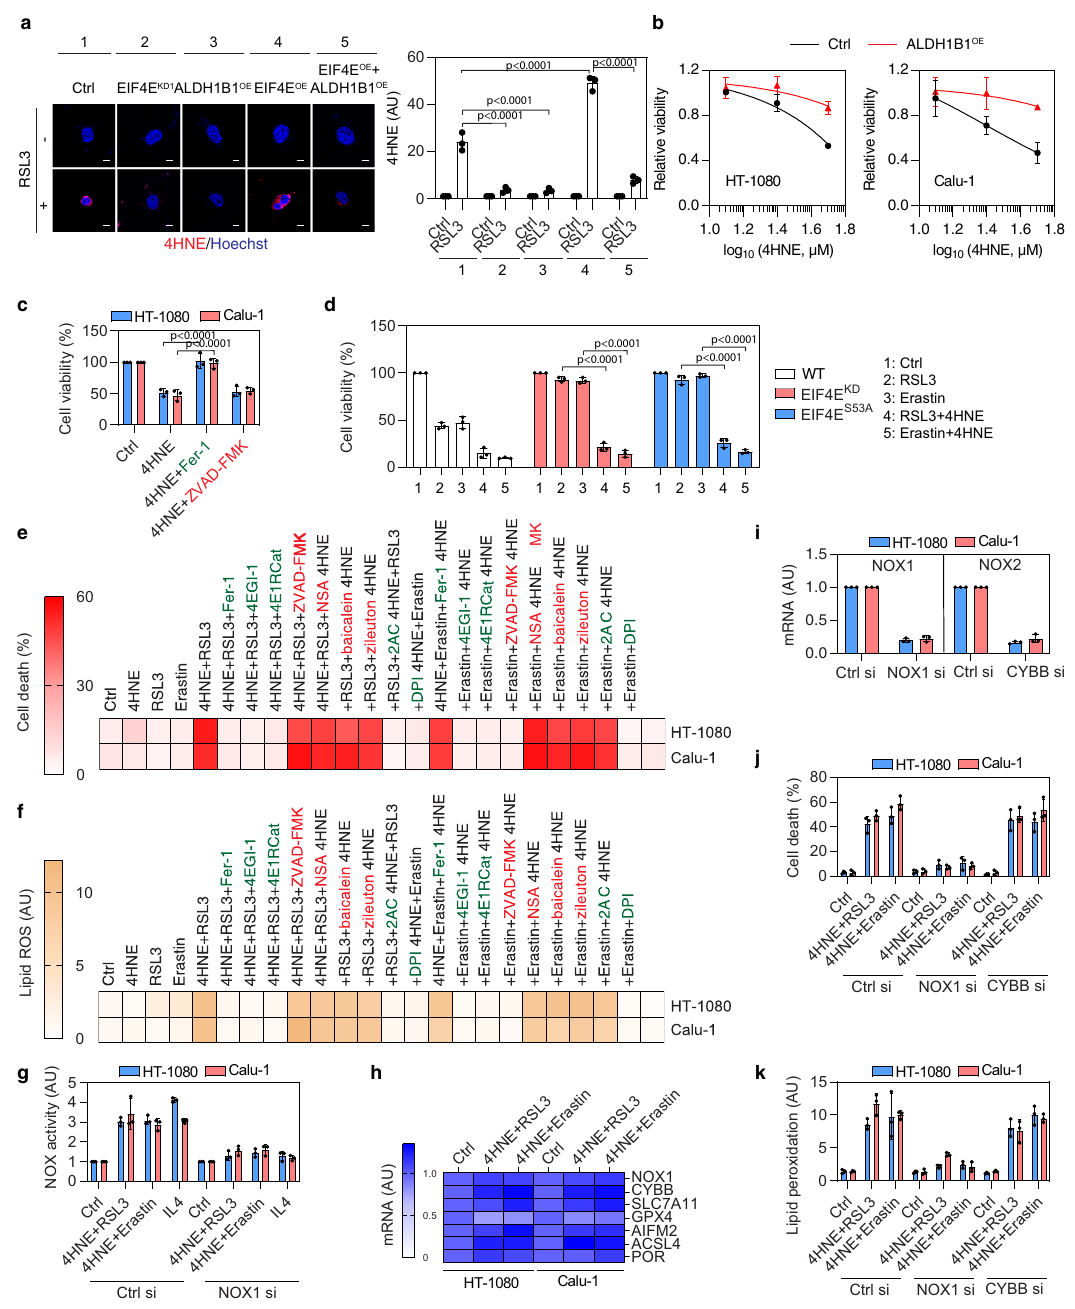
Fig. 4 | 4HNE is a product and mediator of ferroptosis. a Immuno fl uorescence analysis showing staining of 4HNE in indicated Calu-1 cells treated with RSL3 (0.5 μ M, 4h) (scale bar=10 µ m). Mean±SD, n =3; two-way ANOVA with Tukey ’ s multiple comparisons test. b Cell viability of control and ALDH1B1-overexpressing (ALDH1B1 OE )HT-1080and Calu-1 cellstreated with 4HNE for24h.Mean±SD, n =3. c Cellviability of ALDH1B1-knockdownHT-1080and Calu-1 cellstreated with 4HNE (50 μ M) and/or ferrostatin-1 (Fer-1; 1 μ M)/ZVAD-FMK (10 μ M) for 24h. Mean±SD, n =3; one-way ANOVA with Tukey ’ s multiple comparisons test. d Cell viability of indicated HT-1080 cells treated with RSL3 (0.5 μ M) and erastin (5 μ M) in the absence or presence of 4HNE (12.5 μ M) for 24h. Mean±SD, n =3; two-wayANOVA withTukey ’ smultiplecomparisonstest. e , f Celldeath( e ,24h)orlipidperoxidation ( f , 6h) of indicated cells treated with 4HNE (12.5 μ M), RSL3 (0.1 μ M), and